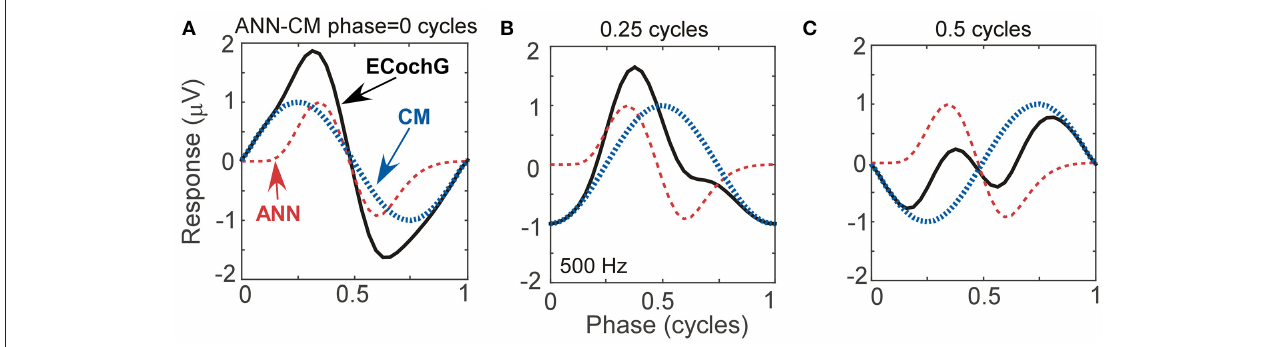
FIGURE 5 | Waveforms generated using simulated signals varied in phase. (A) When the CM and ANN are in phase, the waveform is only slightly distorted, and the amplitude is maximal. (B) When the CM and ANN are ¼ cycle out of phase, the distortion increases. (C) When the CM and ANN are ½ cycle out of phase the distortion is even greater and the overall response magnitude is at a